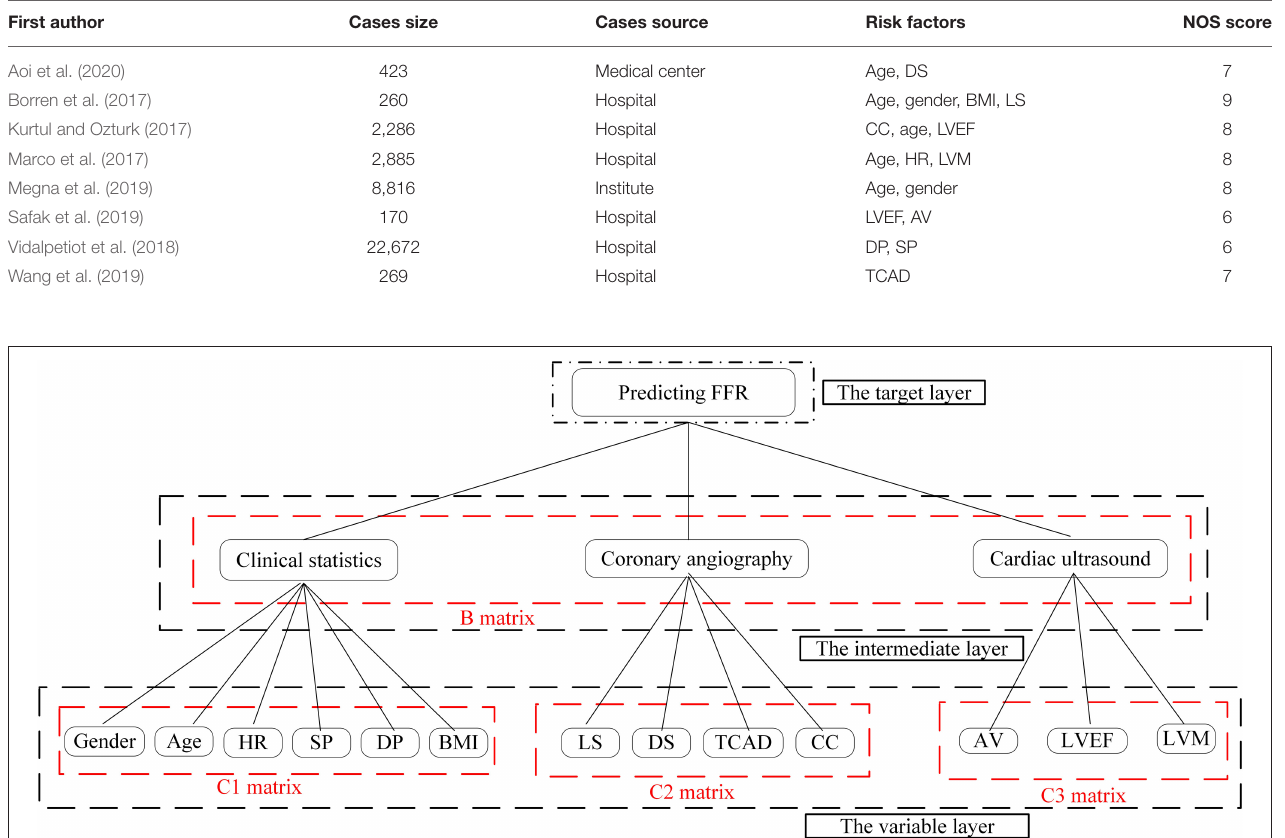
TABLE 1 | The distribution of the included eight pieces of literature.